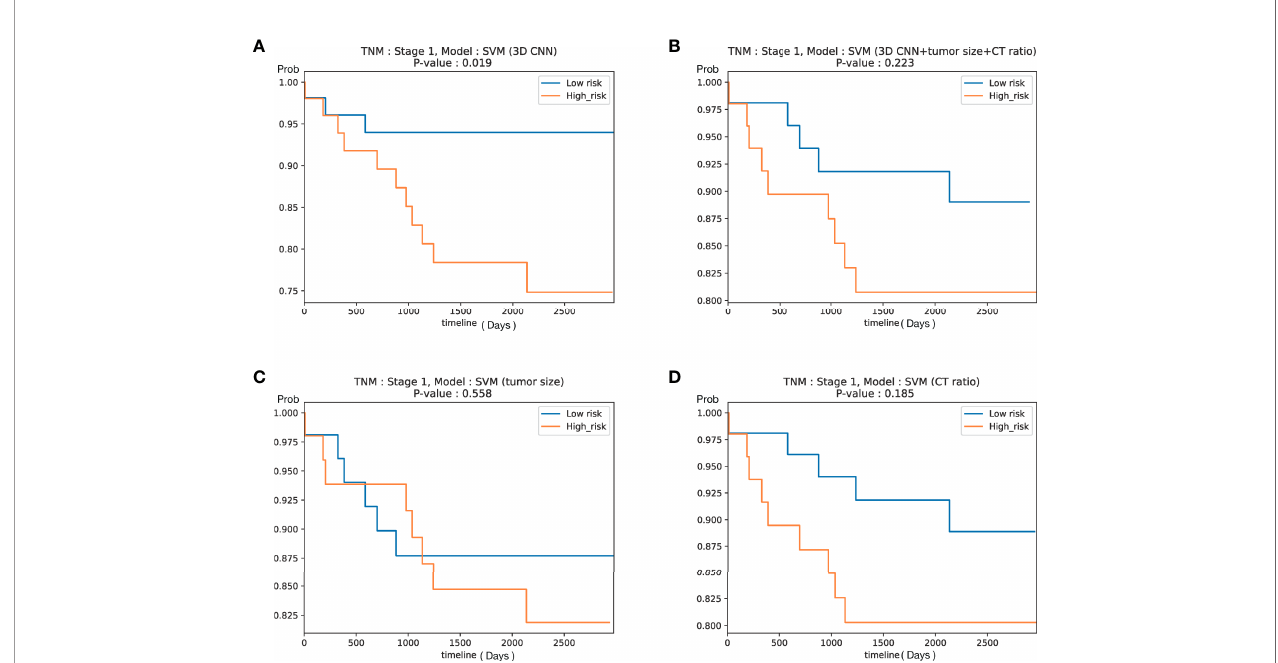
FIGURE 6 | Kaplan – Meier curves according to predicted risk of recurrence for NSCLC patients with stage I in Cohort I (test set only) and Cohort II (105 patients). Curves obtained using (A) DeepCUBIT model, (B) SVM classi fi er using DeepCUBIT features with tumor size and C/T ratio, (C) SVM classi fi er using tumor size alone, and (D) SVM classi fi er using C/T ratio